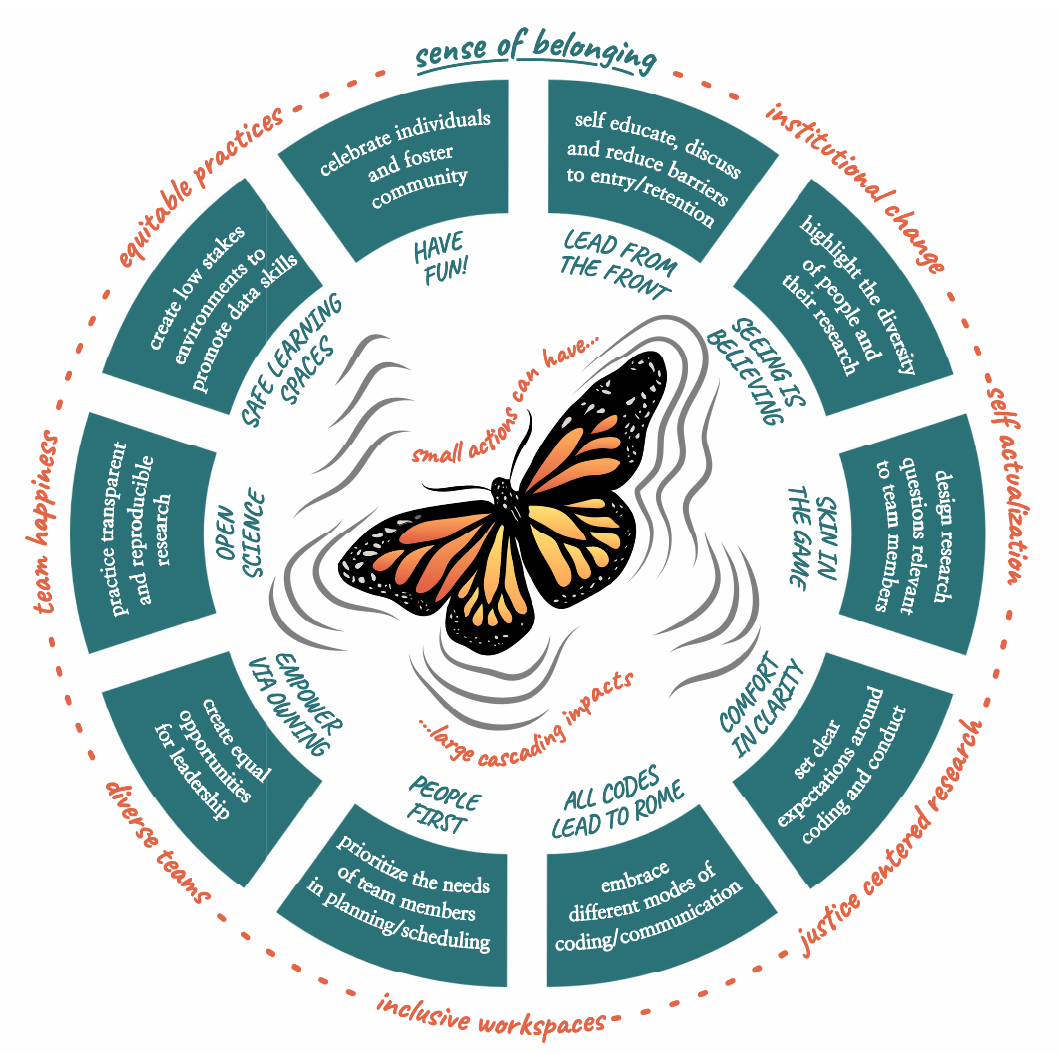
Fig 1. Ten simple rules to cultivate belonging in collaborative data science research teams, visualized here as the “butterfly effect”. Small actions taken by an individual or team, as outlined in our 10 rules, can generate a sense of belonging. This sense of belonging can then cascade to shape other aspects of culture and practice in science and beyond, as illustrated on the outside ring of words. Illustration by A . A . P